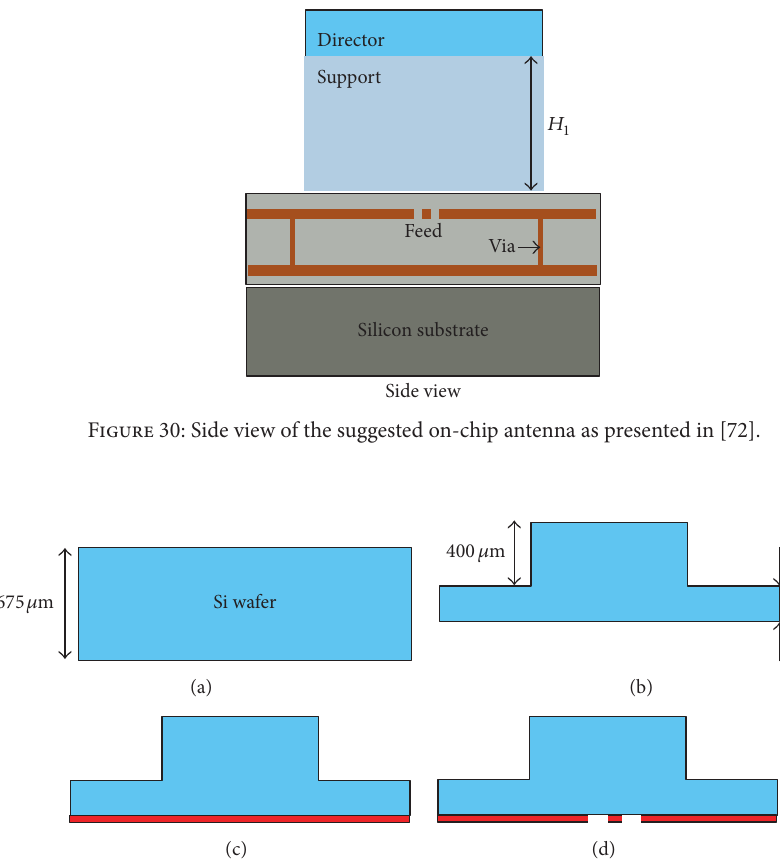
Figure 31: Manufacturing process of the DRA as suggested in [73]. (a) Single silicon wafer. (b) 400 𝜇 m etching. (c) Back side coated with copper film. (d) Back side patterned for the feeding